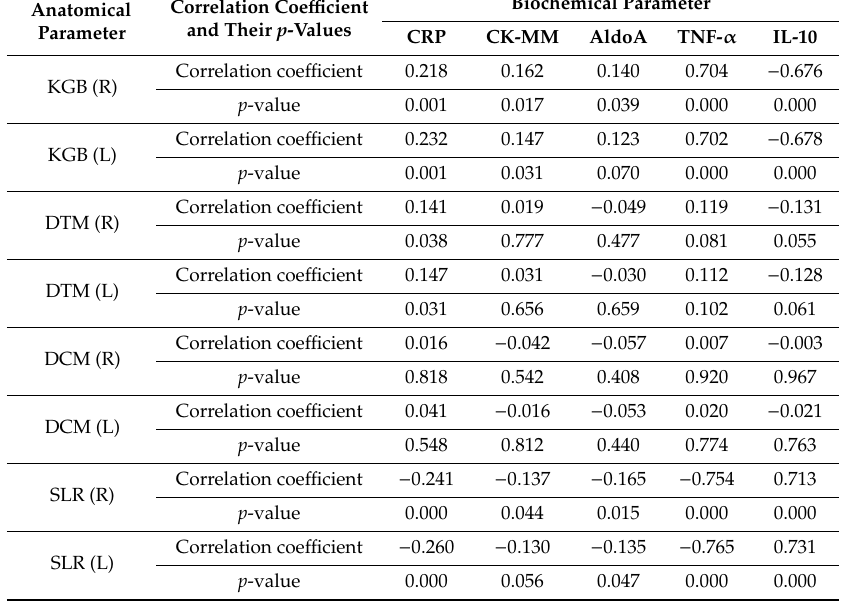
Table 5. Analysis of correlation coe ffi cient and their p -values in relation to anatomical and biochemical parameters of experimental